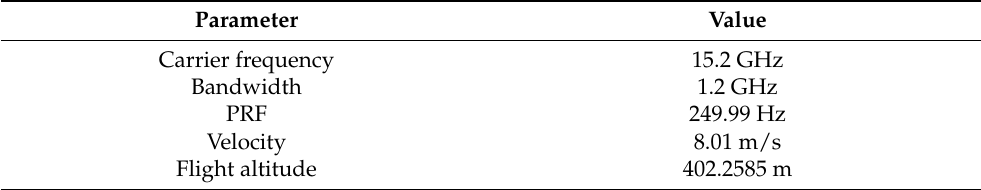
Table 5. Parameters of airborne SAR